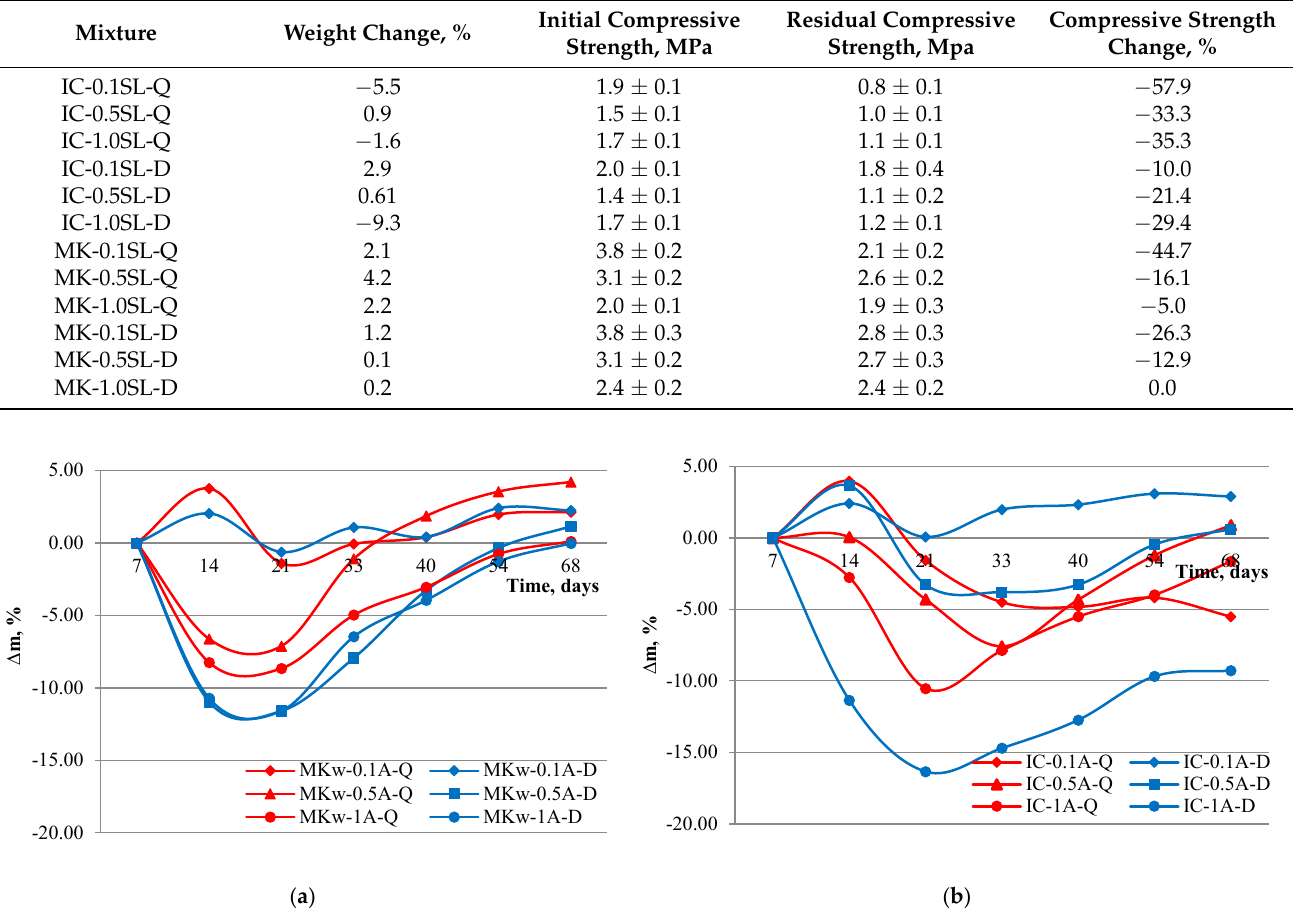
Figure 4. Weight change during sulfate attack test: ( a ) MK based geopolymers, ( b ) IC based geopolymers. The strength reduction after sulfate attack was from 10 to 57.9% for compositions with IC and from 0 to 44.7% for compositions based on MK. Higher strength loss was